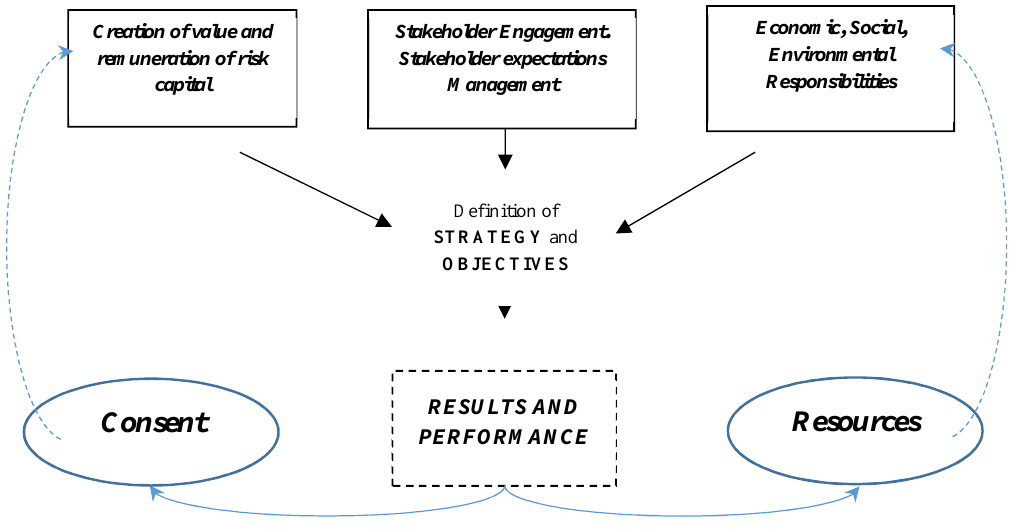
Figure 1: Corporate Governance and Strategic